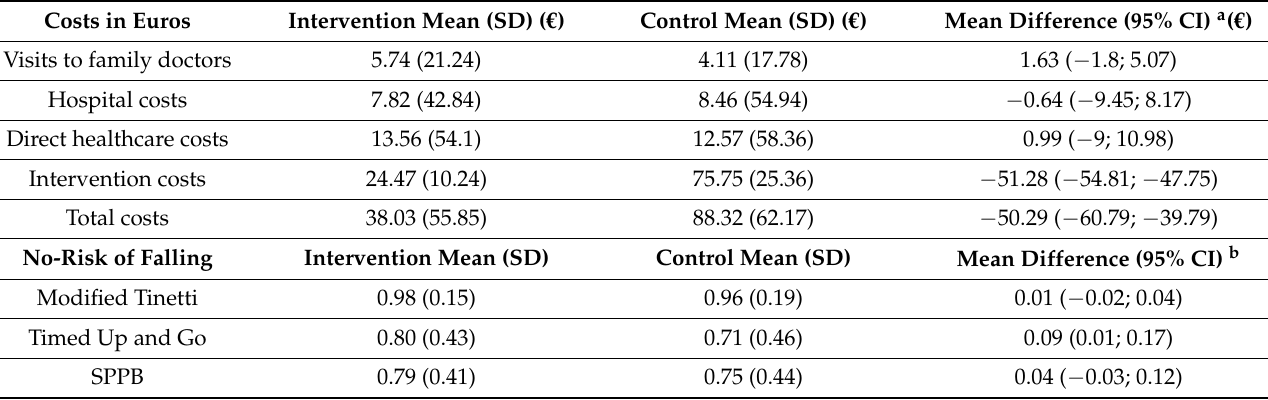
Table 2. Costs and outcome differences of the group and individual sessions at the 12-month visit (unadjusted). Costs in Euros